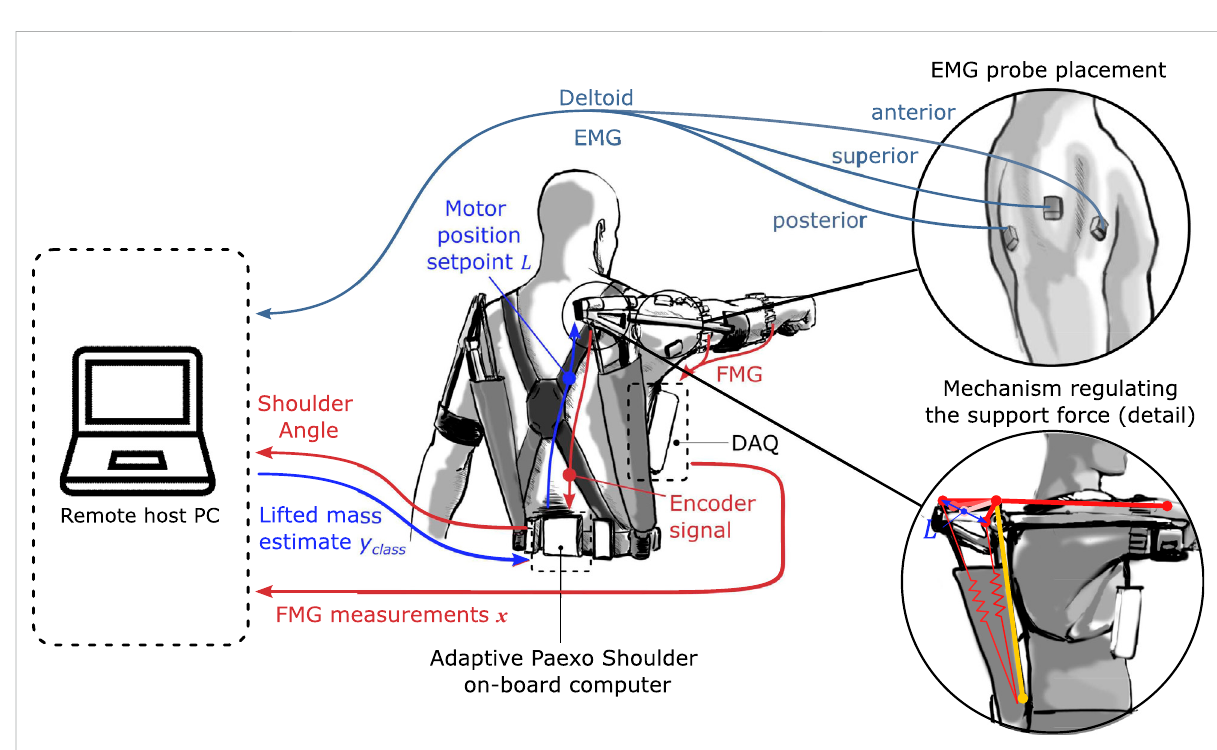
FIGURE 5 Block diagram of the control loop regulating the level of assistance and detail of EMG sensor